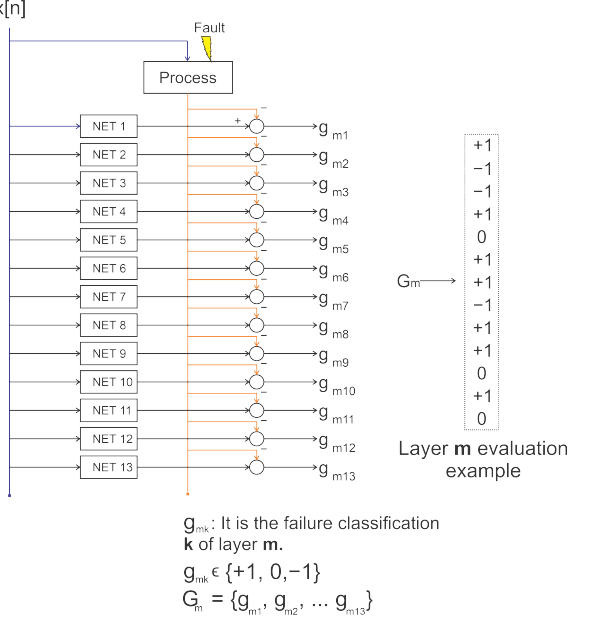
Figure 2. Obtaining the fault signature by analyzing the thresholds present in the residues.